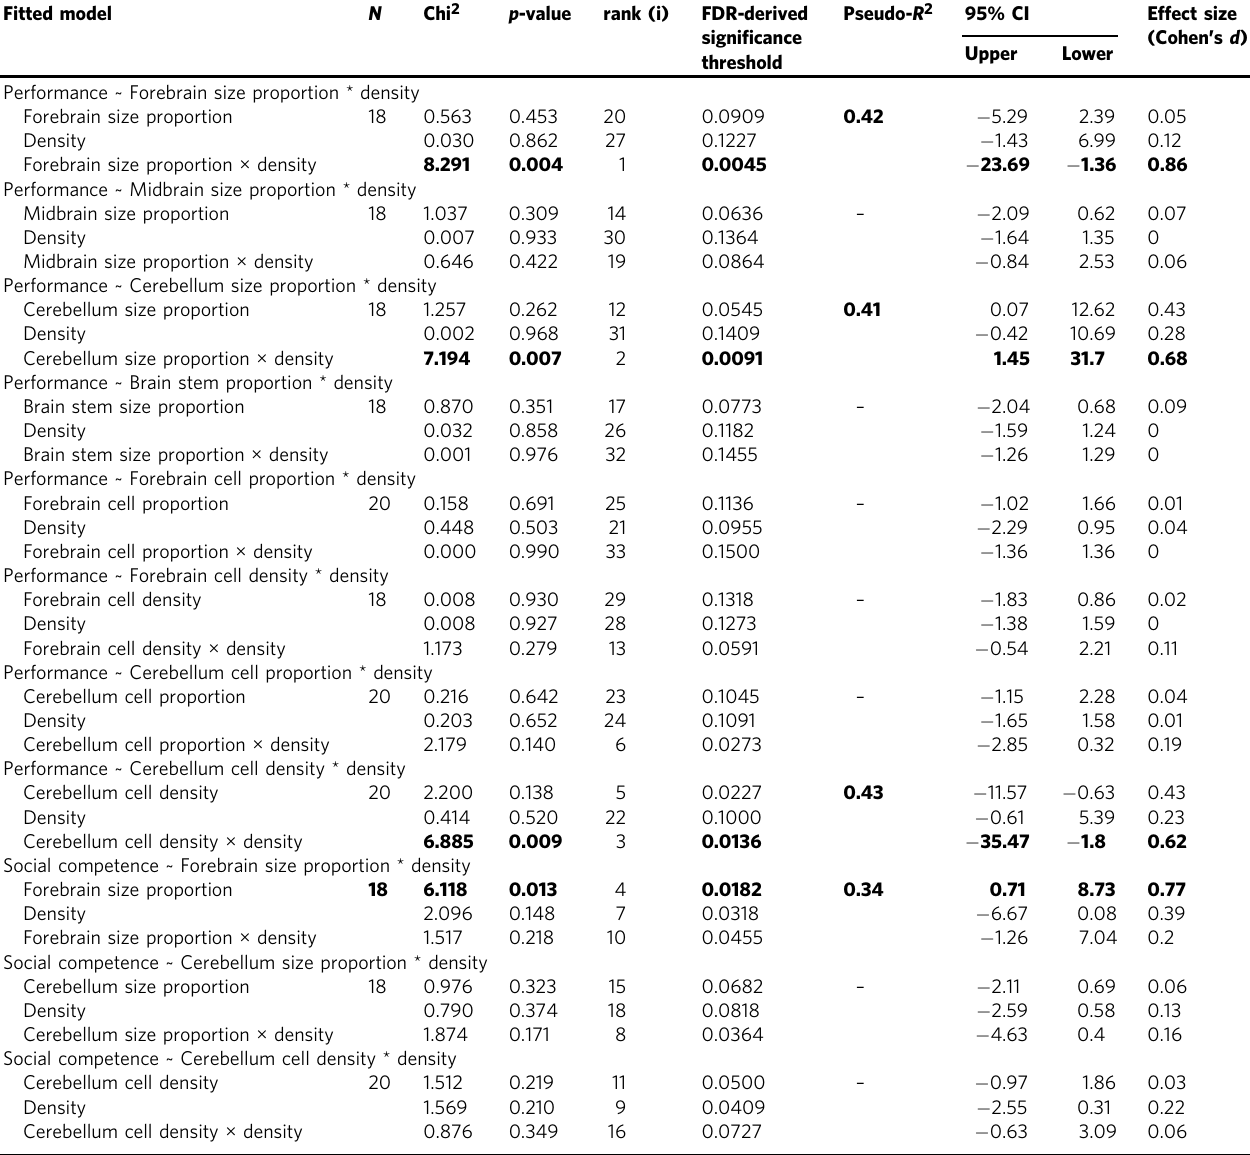
Table 1 Relationship between performance, brain neuroanatomical traits and population density. Fitted